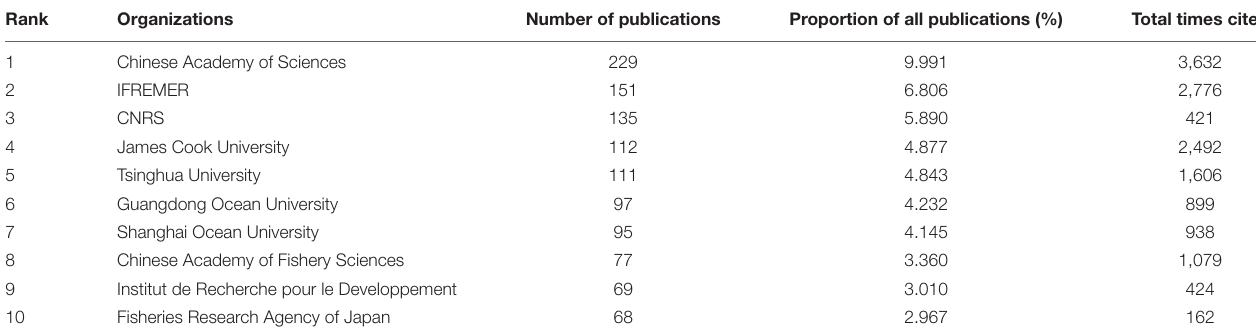
FIGURE 3 | Bibliometric map of the studies of pearl bivalve mollusks as the theme. The size of the dot is proportional to the frequency that a certain country (the region included) appears in the analyzed articles. A line between two dots means that these two countries (regions included) appeared in the same article. The positive correlation between the thicker line and the higher frequency indicated that the two countries (regions included) appeared continually in the same articles. The color stands for the year when a certain country (the region included) most frequently occurred in articles. TABLE 3 | Among the studies related with pearl bivalve mollusks as the theme, the numbers of publications, the proportion of all publications, and the total times cited for the top 10 organizations ranked by the number of publications based on WOS. Rank Number of publications Proportion of all publications (%) Total times